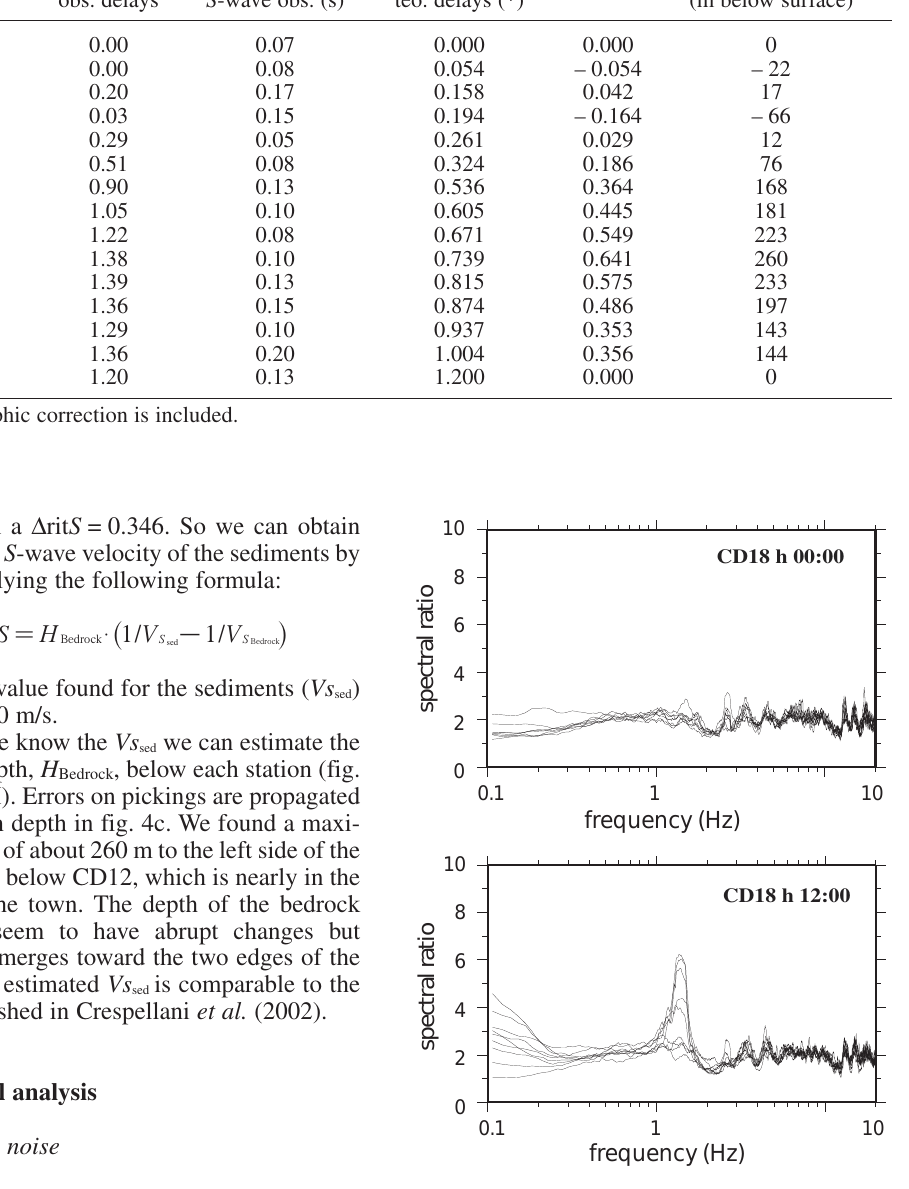
Fig. 5 . Example of H / V spectral ratios of noise recordings at CD18. We show the time windows recorded around midnight and noon for 10